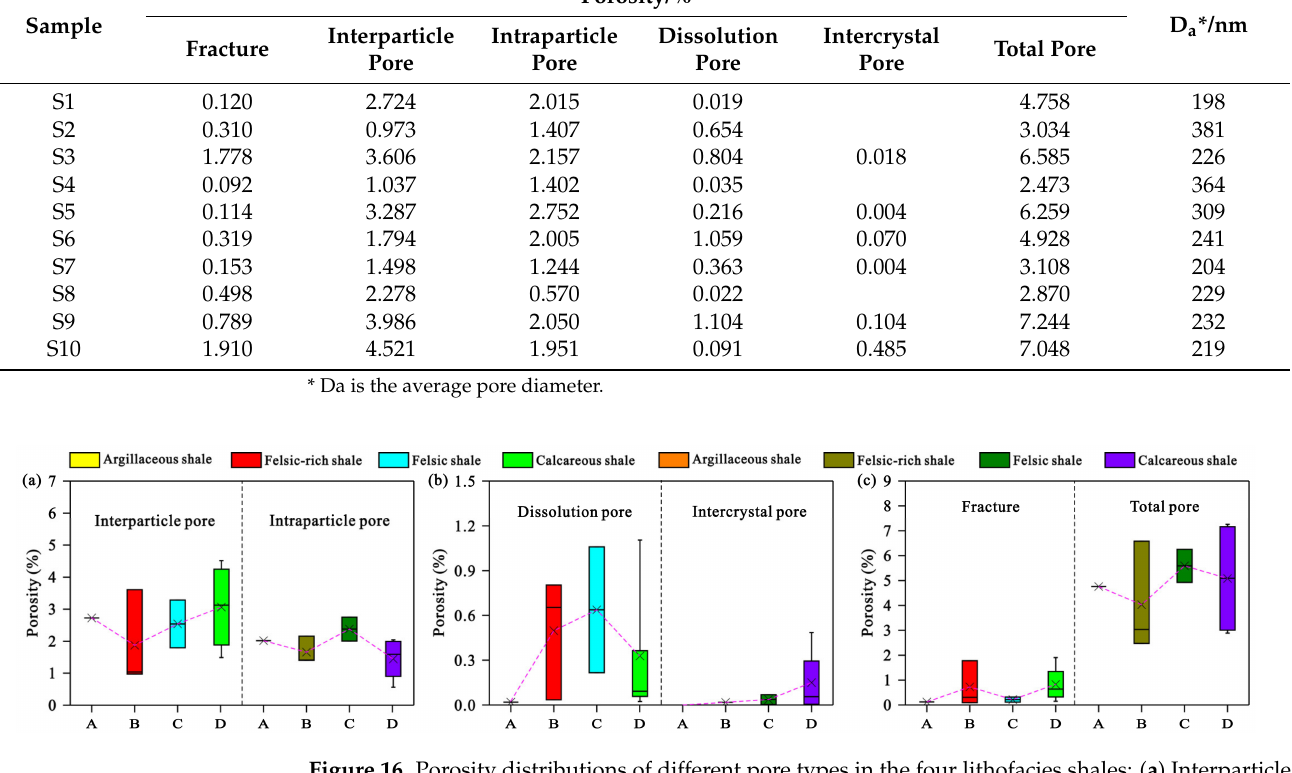
Figure 16. Porosity distributions of different pore types in the four lithofacies shales: ( a ) Interparticle pore and intraparticle pore; ( b ) Dissolution pore and intercrystal pore; ( c ) Fracture and total pore. The total porosity of the four types of pores considered ranges from 2.473% to